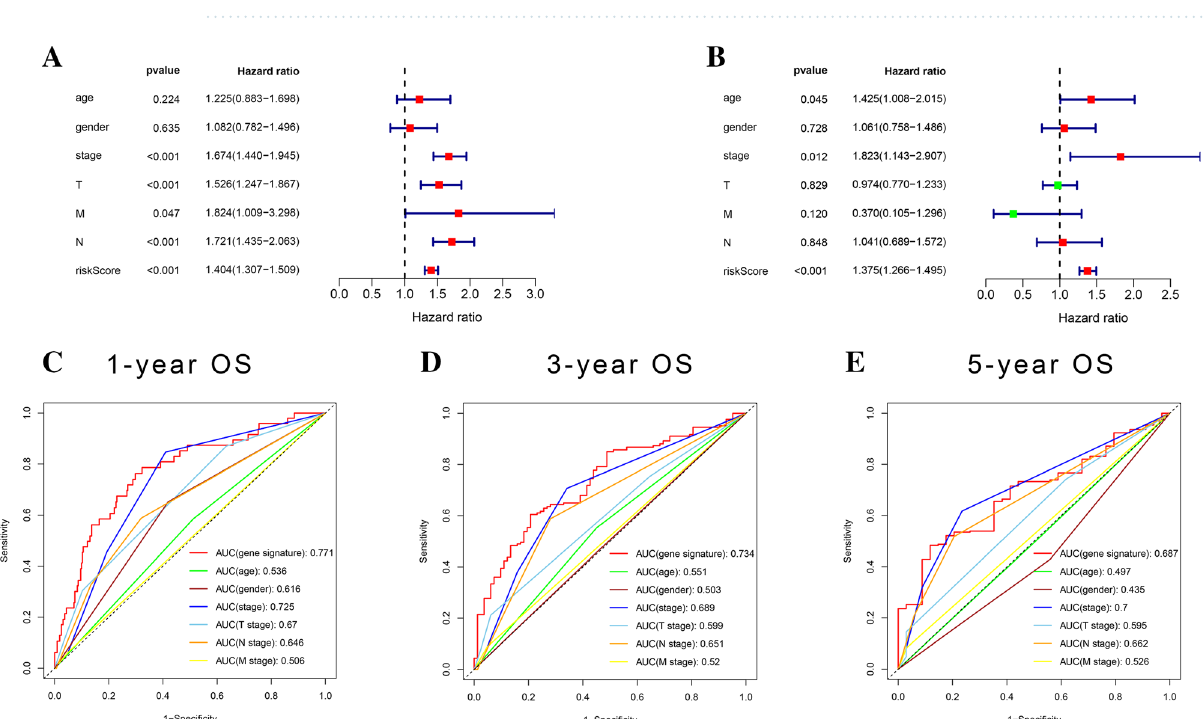
Figure 7. Clinical relevance. ( A , B ) Univariate and Multivariate Cox regression analysis of clinical factors related to overall survival in the TCGA cohort. ( C – E ) ROC curve demonstrated the risk prediction compared with other clinical factors in the TCGA